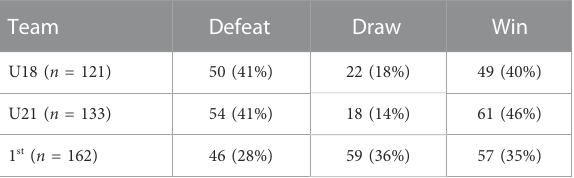
TABLE 3 Number of individual match observations per team and match outcome. Data presented as n (%). Team